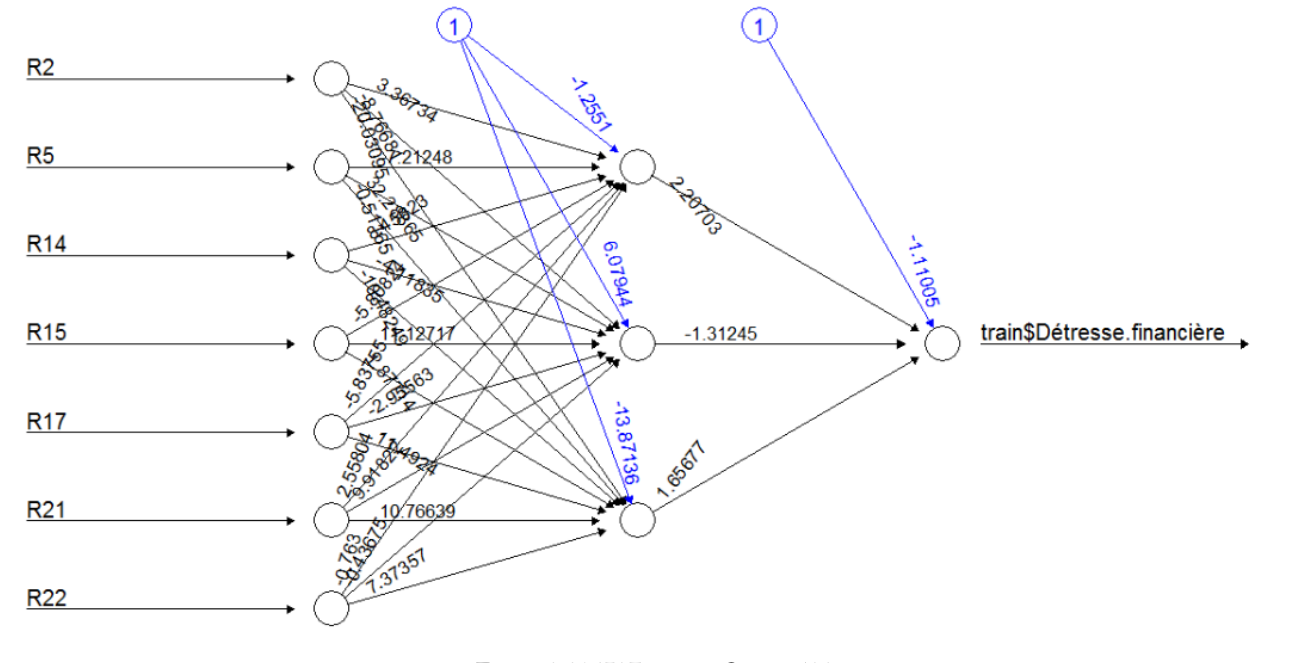
Figure A3. Neural networks model for lasso selection technique, year